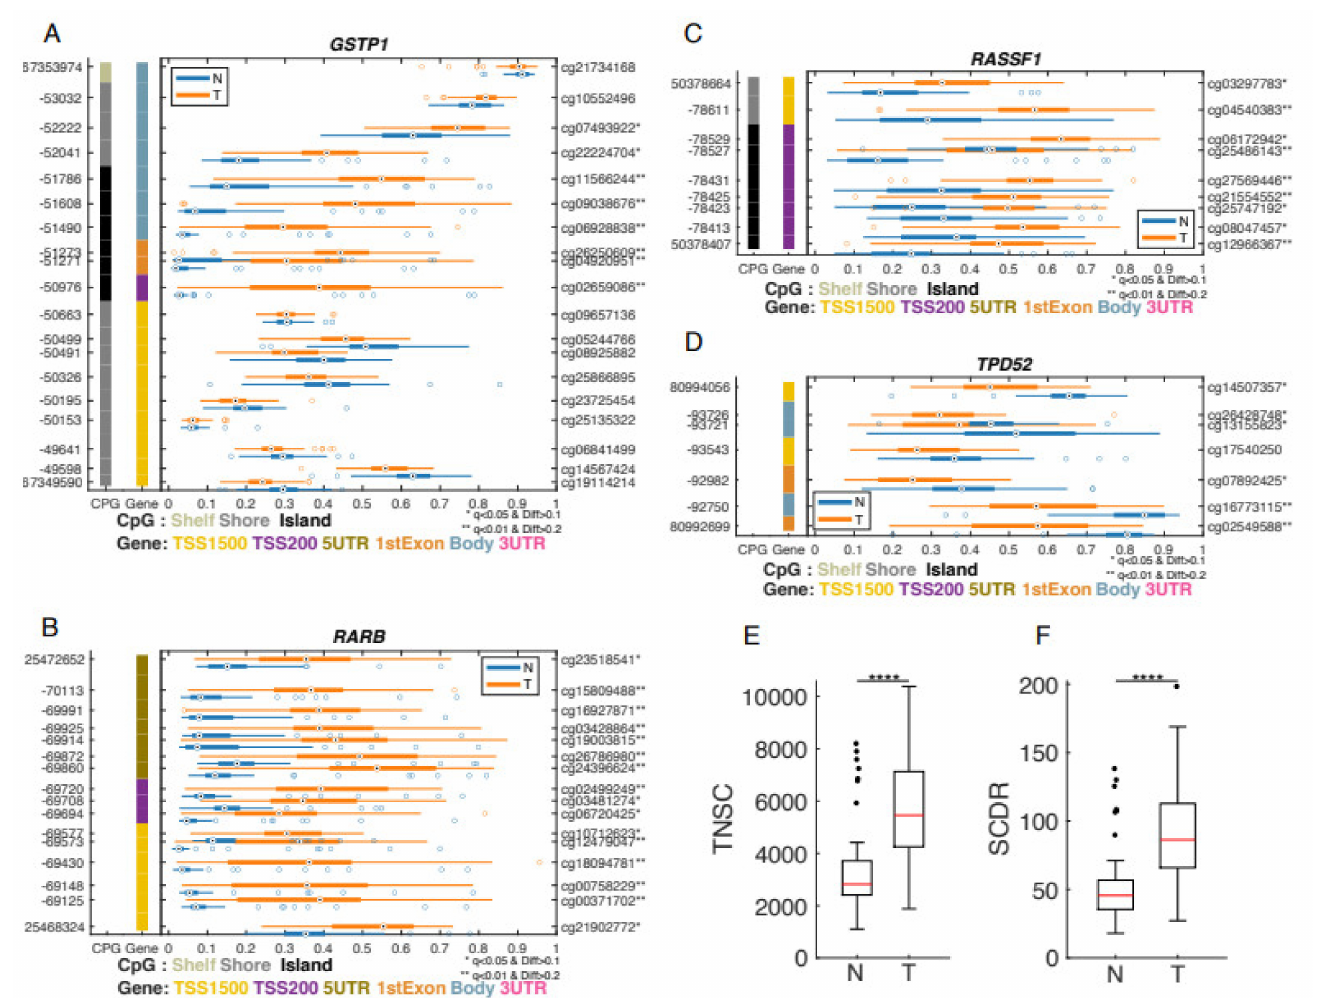
Figure 2. Differently methylated genes in tumor vs. normal tissues. GSM plots comparing the methylation levels between normal and tumor tissues for GSTP1 ( A ), RARB ( B ), RASSF1 ( C ), and TPD52 ( D ). The selected CpG probes are shown on the y -axis with probe-id on the right y -axis and the genomic position on the left y -axis. The methylation level for each CpG probe is shown along the x -axis ( β -value) with a boxplot for normal samples (N) in blue and tumor samples (T) in orange. The leftmost column indicated CpG island while the second column indicates the CpG probes location in the gene. Total number of stem cell divisions per stem cell (TNSC) boxplot comparing tumor vs. normal tissues ( E ), and stem cell division rate (SCDR) boxplot ( F ). **** p <